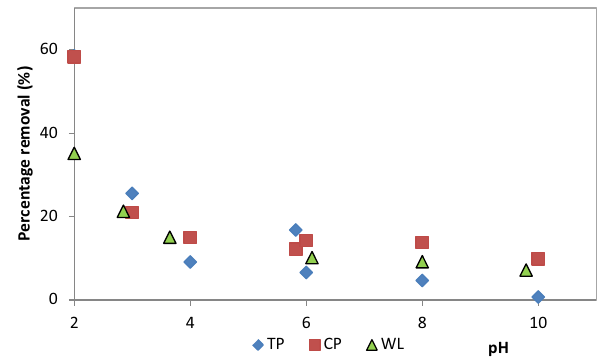
Fig. 3 The effect of pH on the removal of AB25 using WL, CP